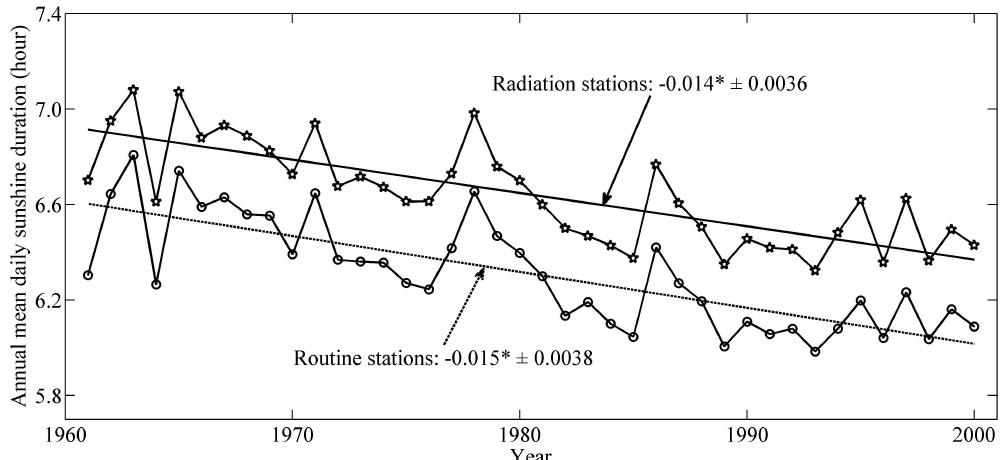
Fig. 7. Time series of annual mean daily sunshine duration during 1961 ∼ 2000. The five-pointed star symbols denote values averaged over all radiation stations, and the circle symbols denote values averaged over all CMA routine stations. The star symbol (*) denotes a trend that passes the significance test ( p < 0 . 05). The unit of the trend is hour year − 1